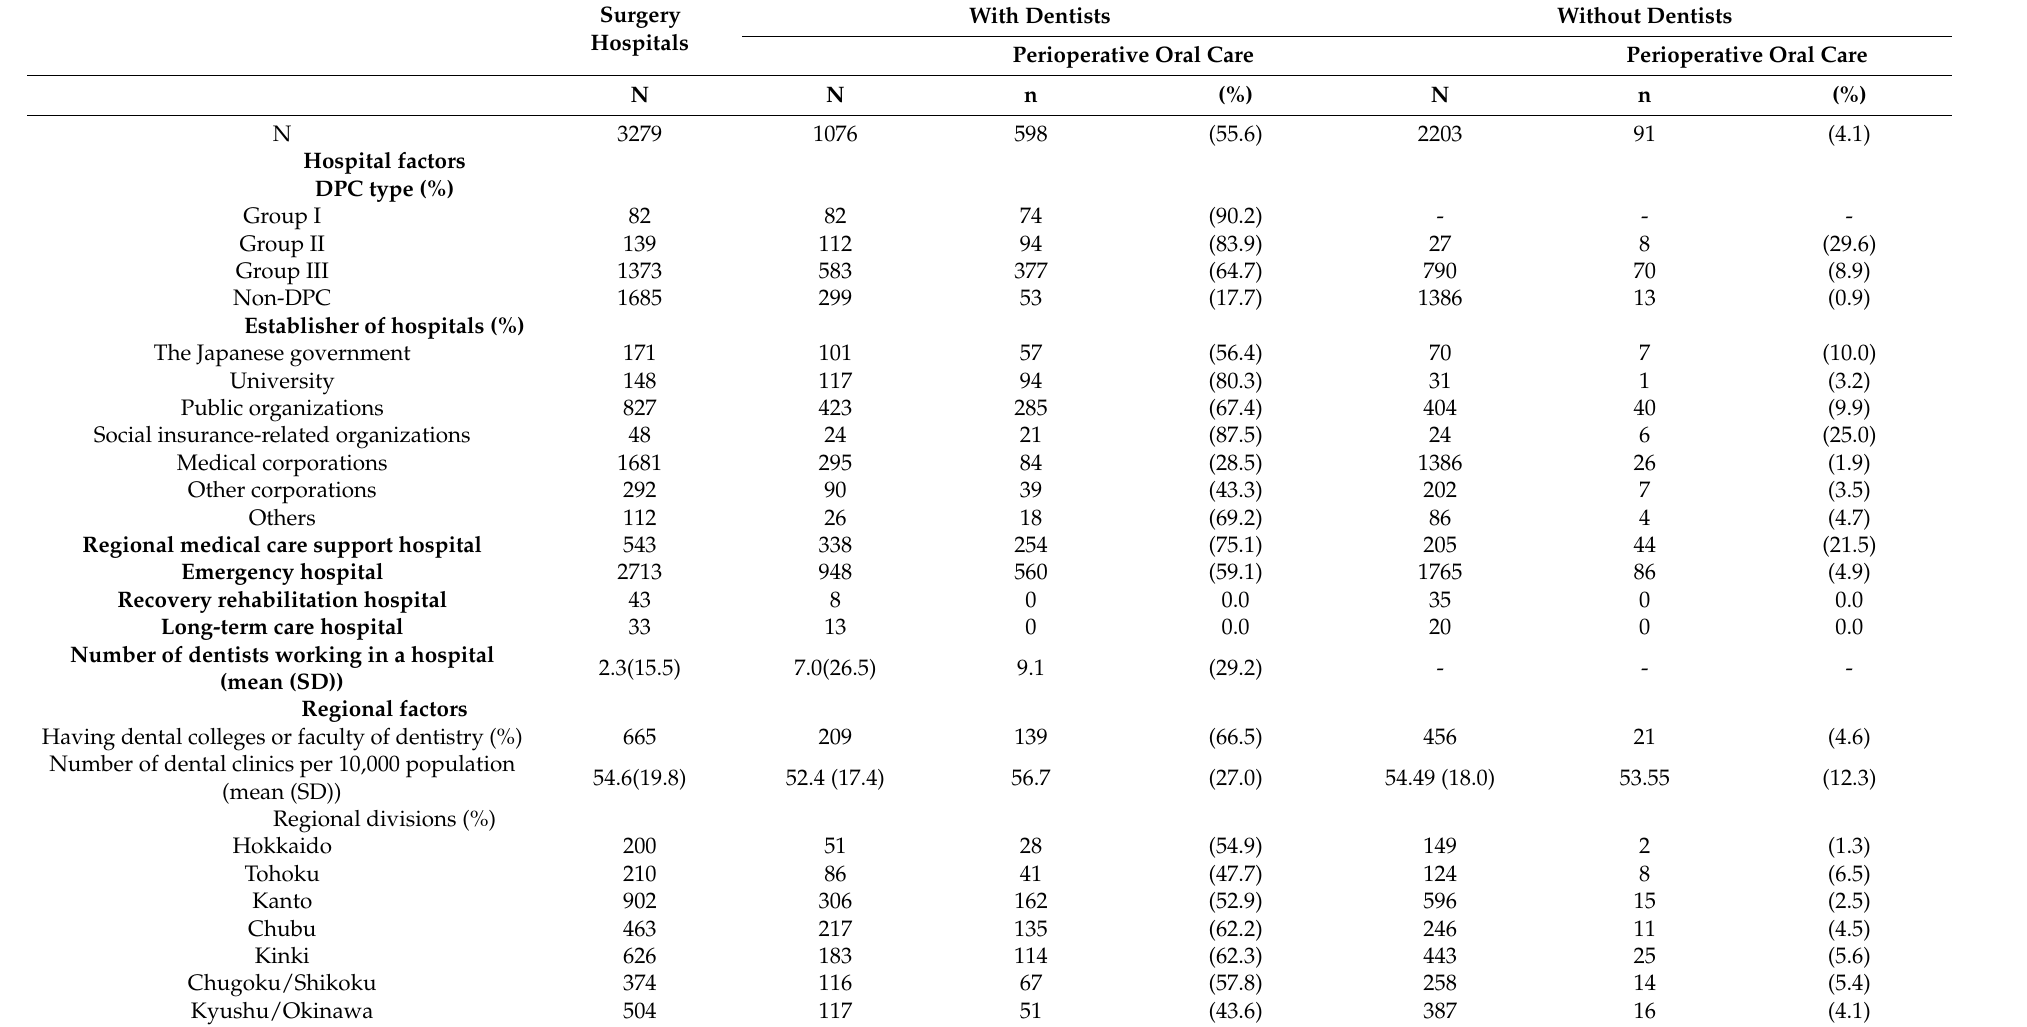
Table 2. Characteristics of surgery hospitals with/without dentists and providing perioperative oral care.